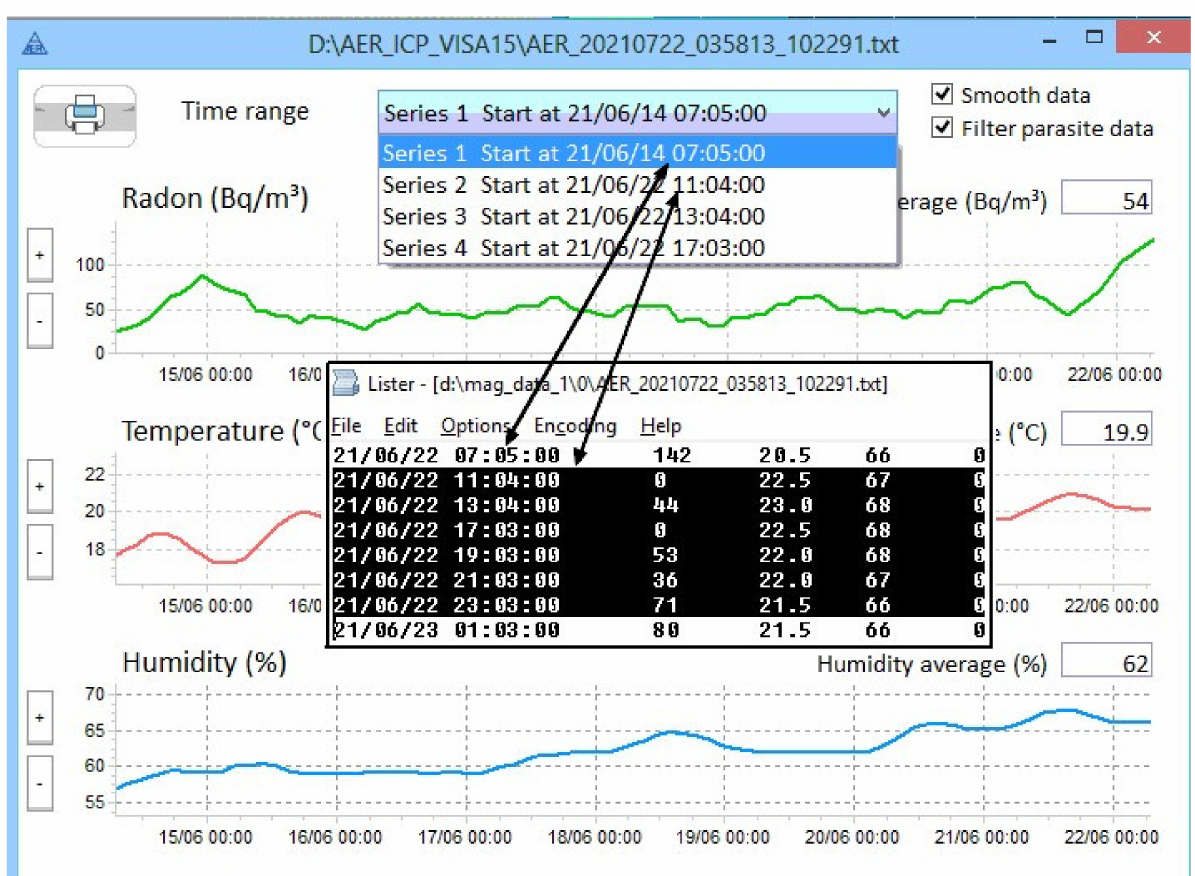
Figure 10. Gaps in AER +C data (format of 21/06/14 is